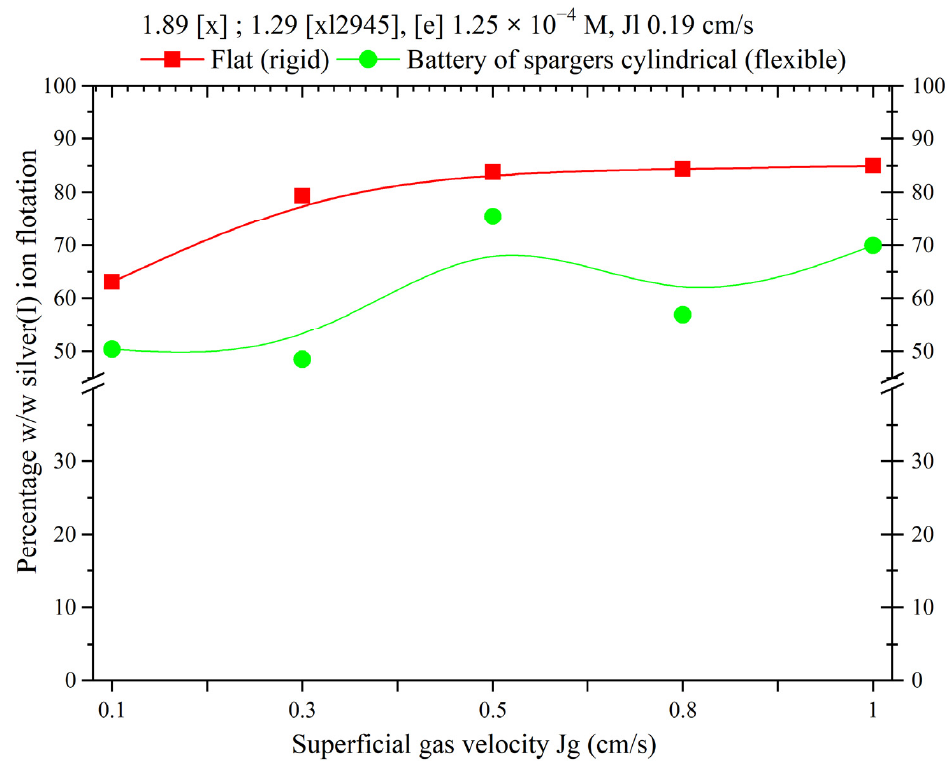
Figure 17. Percentage of w / w silver(I) recovery by ion flotation vs. superficial gas velocity, 1.89 × 10 − 4 M collector–1.29 × 10 − 4 M [xl2945], [e] 1.25 × 10 − 4 M, and Jl 0.19 cm/s.